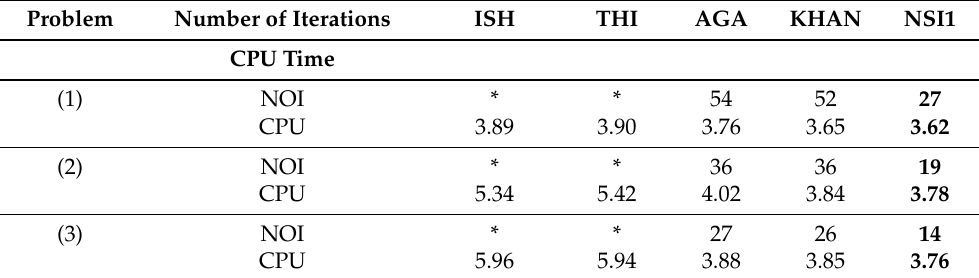
Table 8. Results of comparison of two-step methods for system of equations.